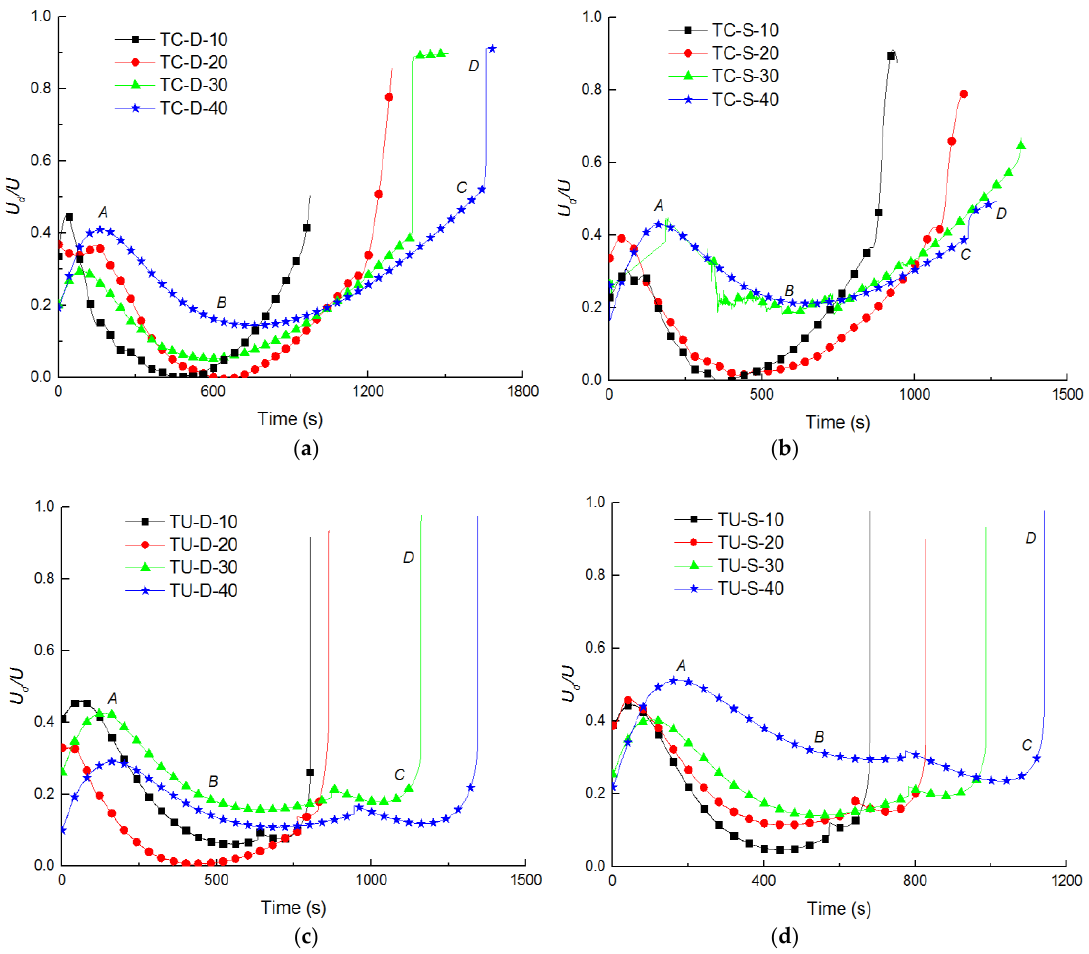
Figure 10. Evolution of U d /U with loading time under triaxial loading and unloading tests for dry and saturated sandstone specimens ( a ) TC-D; ( b ) TC-S; ( c ) TU-D; ( d ) TU-S.